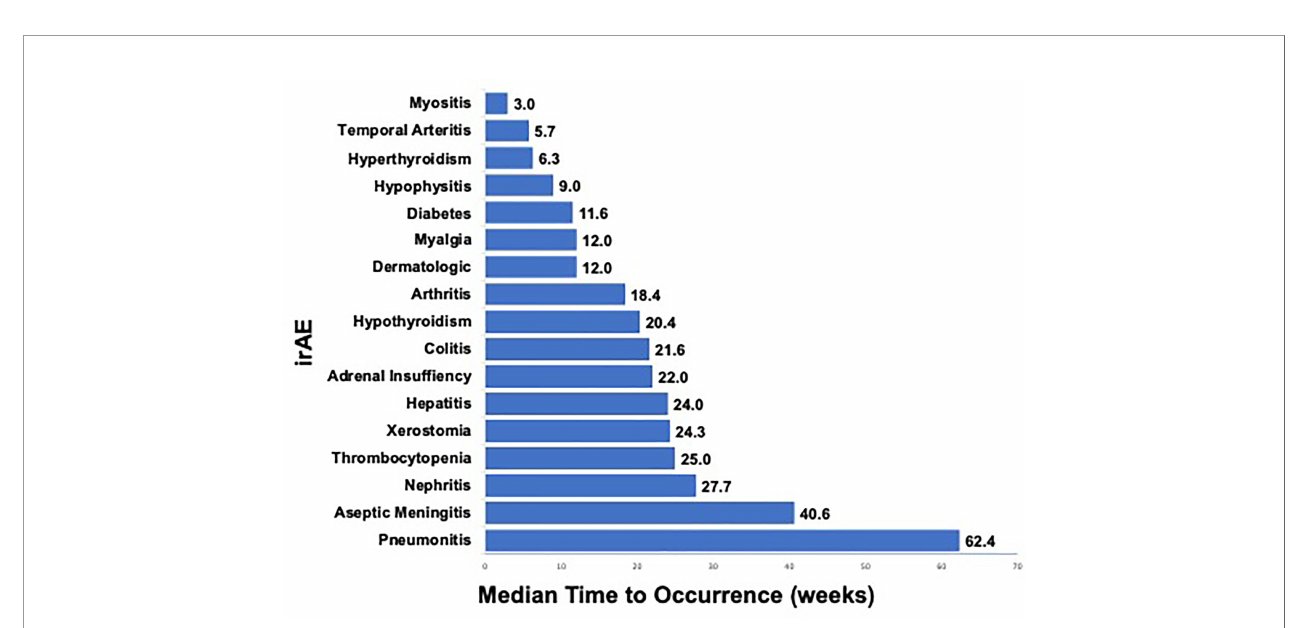
FIGURE 2 | Median Time (weeks) to irAE Occurrence in PD-1 Treated Advanced Melanoma Patients. a. Legend: Median time (in weeks) from start of therapy to development of any-grade irAE that occurred in ≥ 1 patient after anti-PD-1 therapy for advanced melanoma is shown. Range (in weeks) from start of therapy to development of irAE is shown on